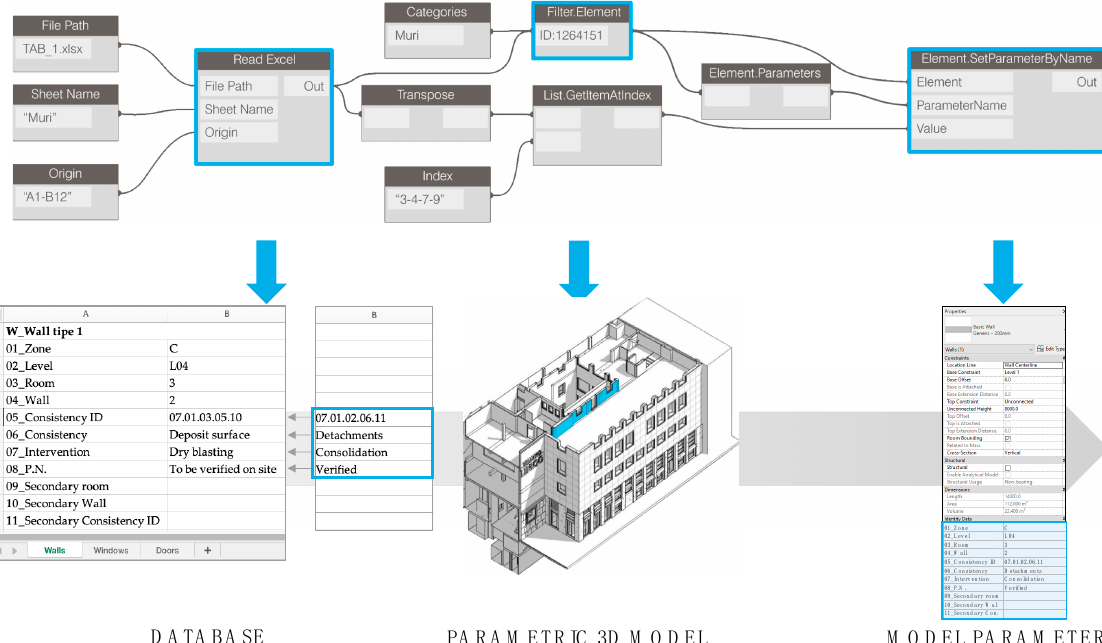
Figure 9. Process of updating the attributes.